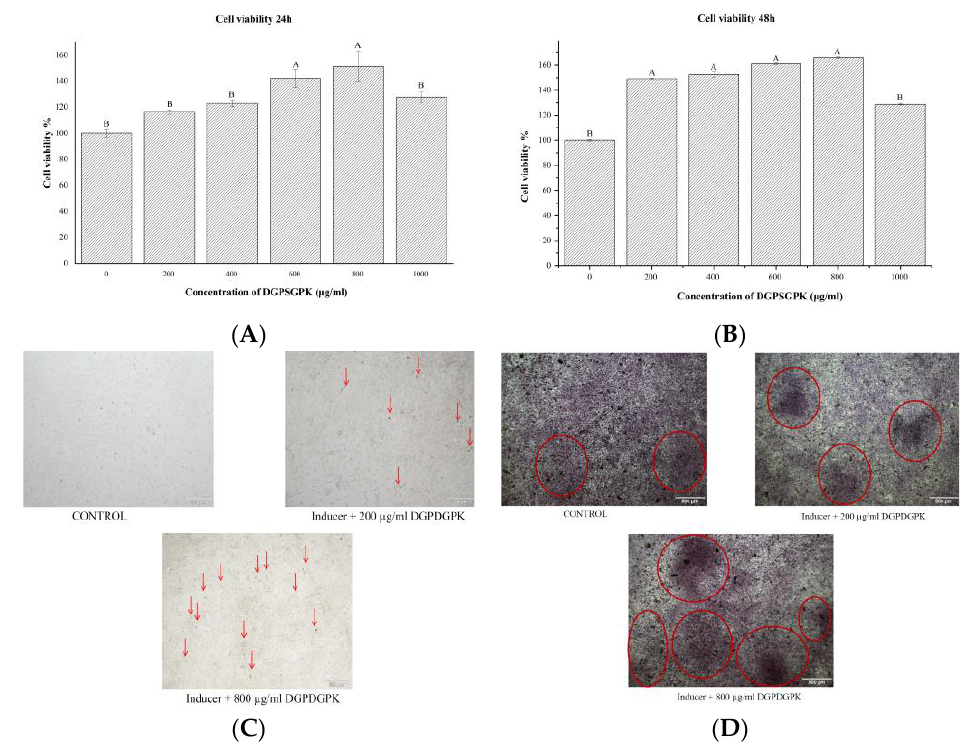
Figure 11. Effects of DGPSGPK with different concentrations on osteoblast proliferation, differentiation, and mineralization. ( A ) and ( B ) cell viability of MC3T3-E1 cells; ( C ): ALP staining at 7 days; ( D ): MC3T3-E1 mineralization staining at 21 days. MC3T3-E1cellscandifferentiateintomatureosteoblastswiththecultureof β